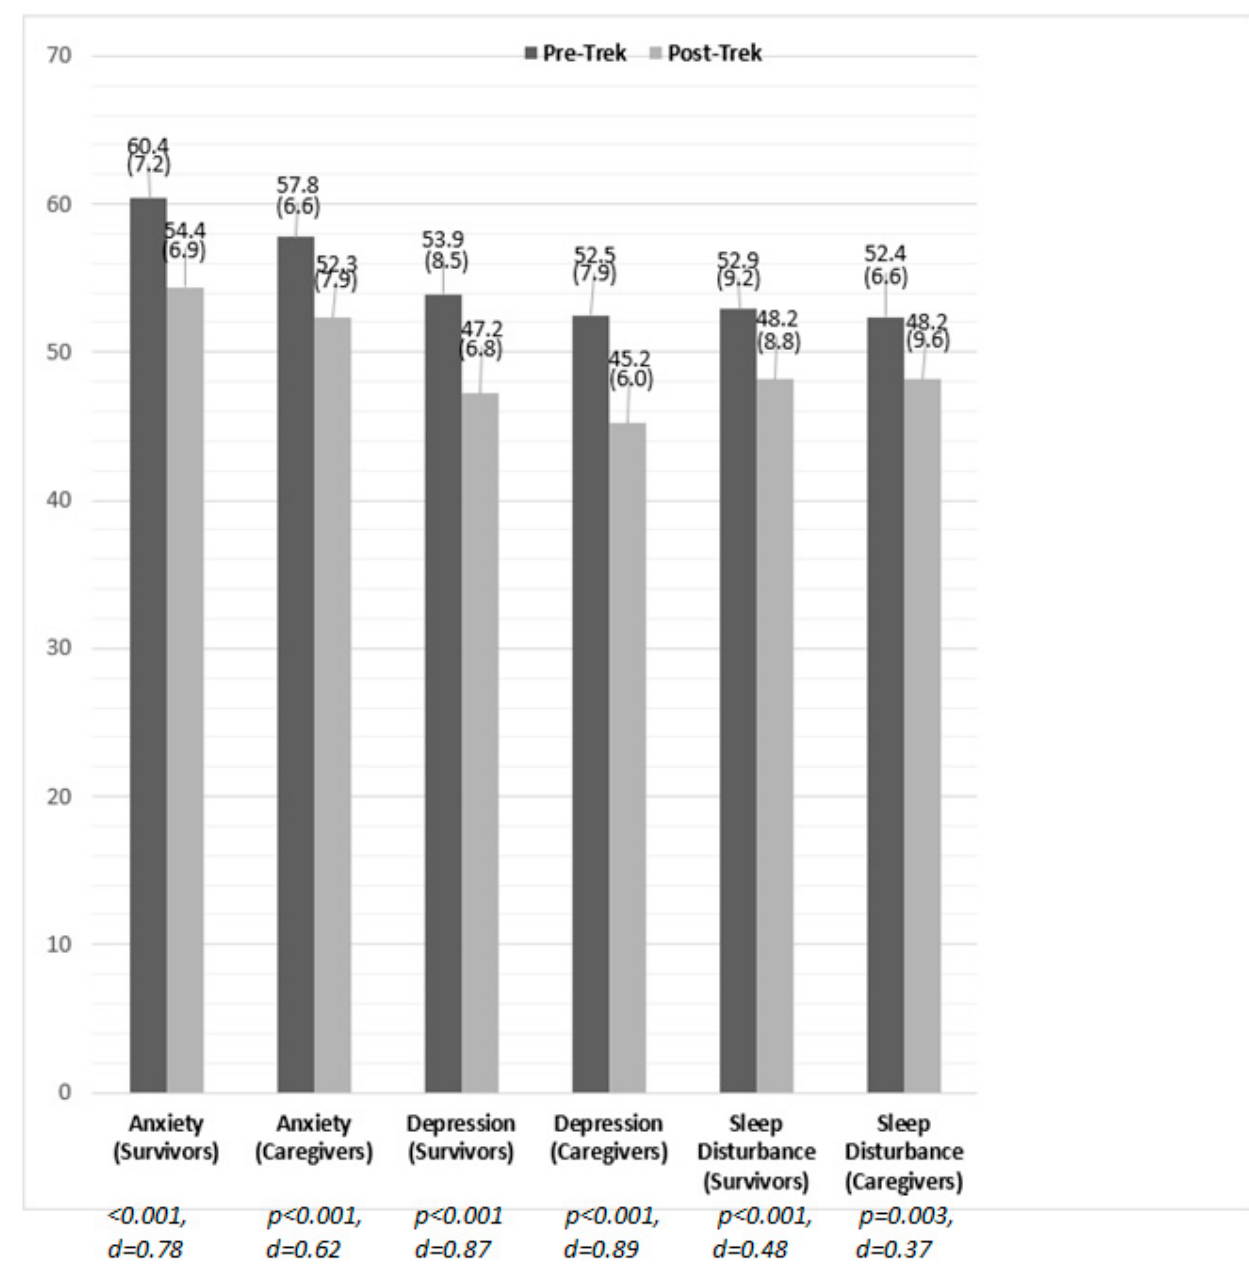
Figure 2. Pre-Post Changes in PROMIS Anxiety, Depression and Sleep Disturbance among Survivors ( n = 139–141) and Caregivers ( n = 37–38), 2016–2021. Note: Significance values and effect sizes represent pre-post changes within each respective group, and not comparisons between survivors and caregivers.